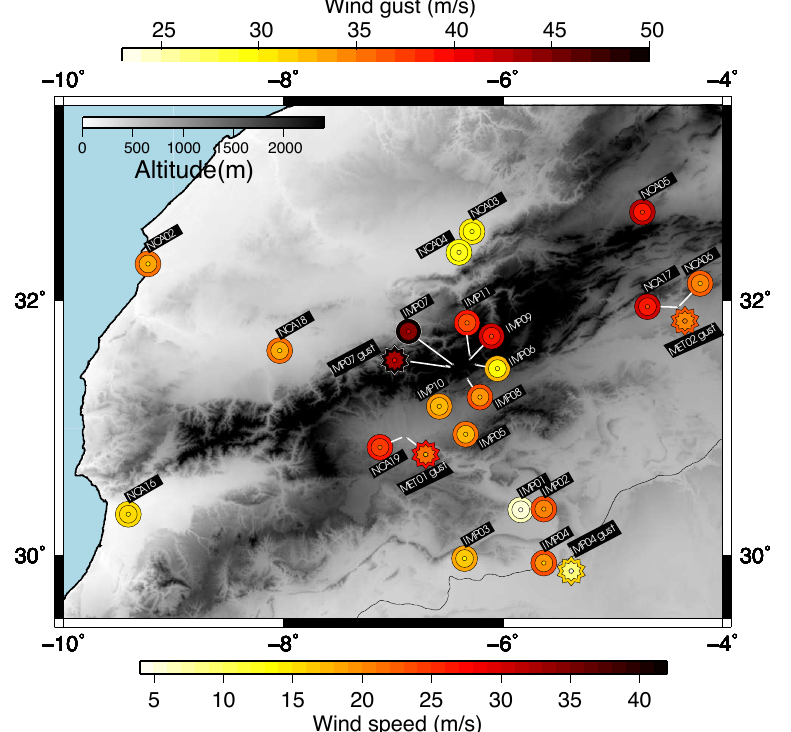
Figure 10. 50-year return values of the 10-min wind speed (circles) and wind gust (stars) for all sites within the observational dataset (note there is a different color scale for each variable). The color of the mid symbols represents the median of the 50-year return values. Outer (inner) circles are illustrative of the 95th (5th) percentiles of the respective combined probabilities from the successful experiments at each site. Gray shading stands for the topography of the